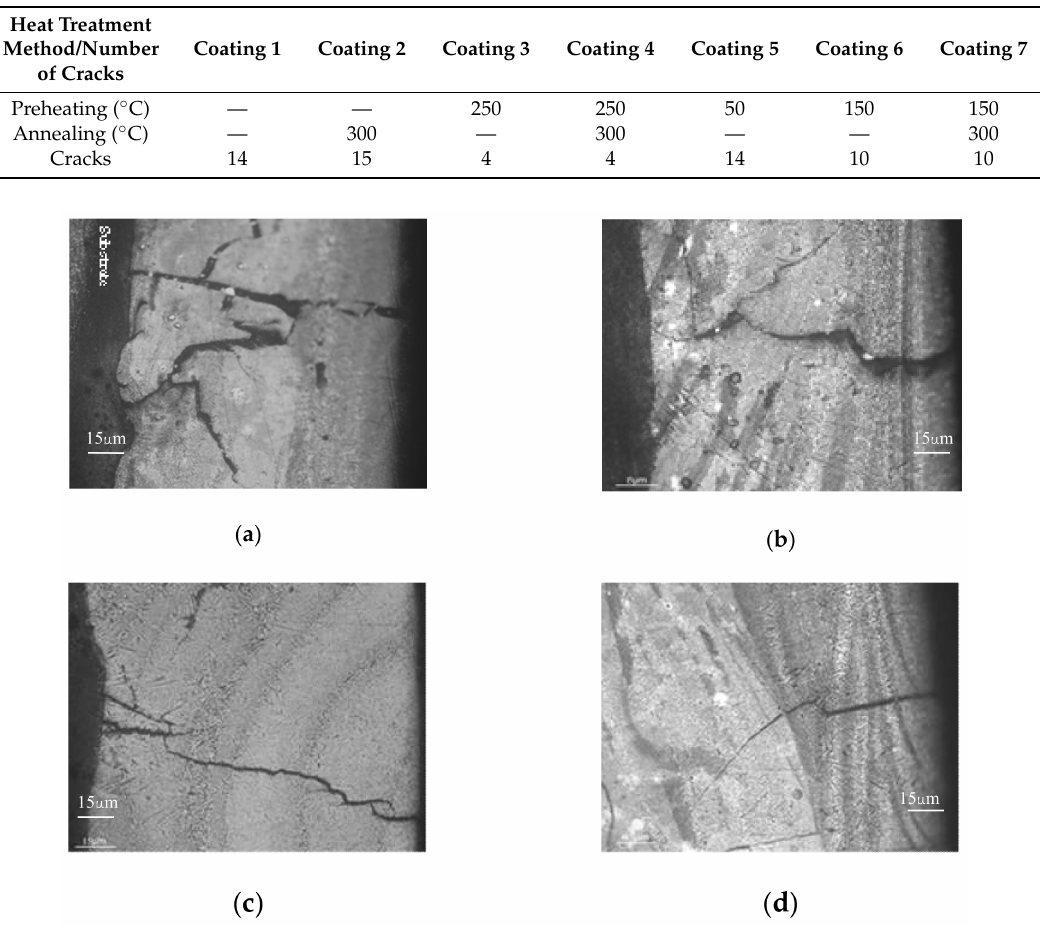
Figure 4. Crack characteristics in the coatings by different heat treatments. ( a ) coating 1, ( b ) coating 2, ( c ) coating 3, ( d ) coating